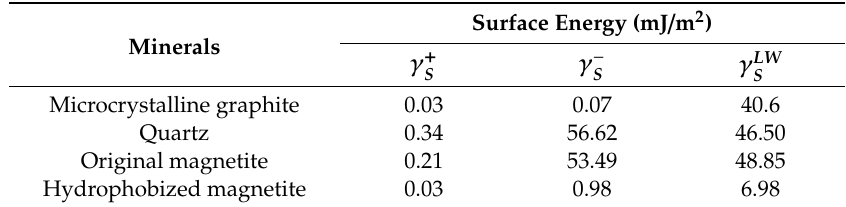
Table 2. Values of components of surface energies of microcrystalline graphite, quartz, and original and hydrophobized magnetite.